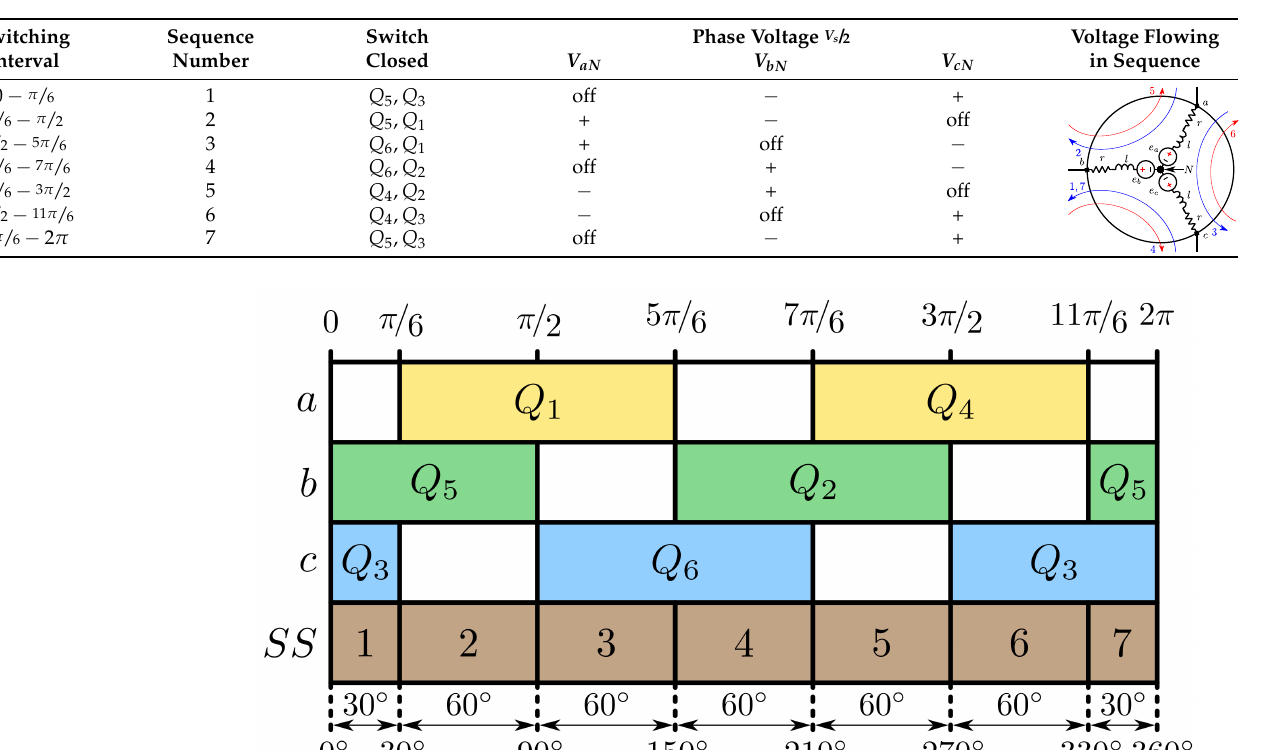
Table 2. The three-phase full-bridge inverter 120-degree conduction mode.